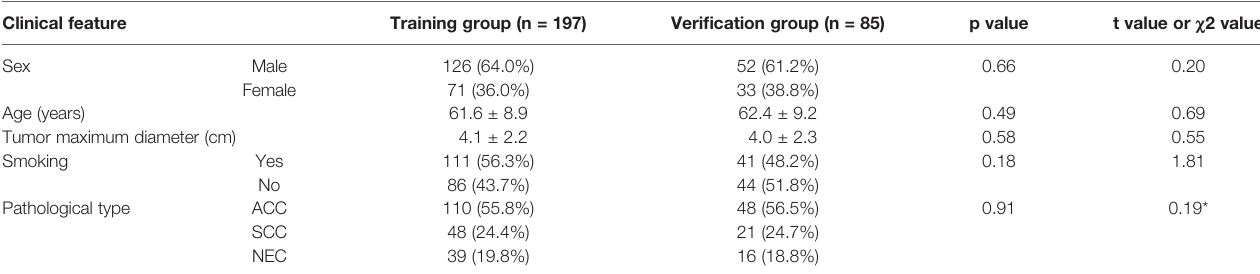
TABLE 1 | Comparison of the clinical data and pathological staging results of patients in the training and validation groups. Clinical